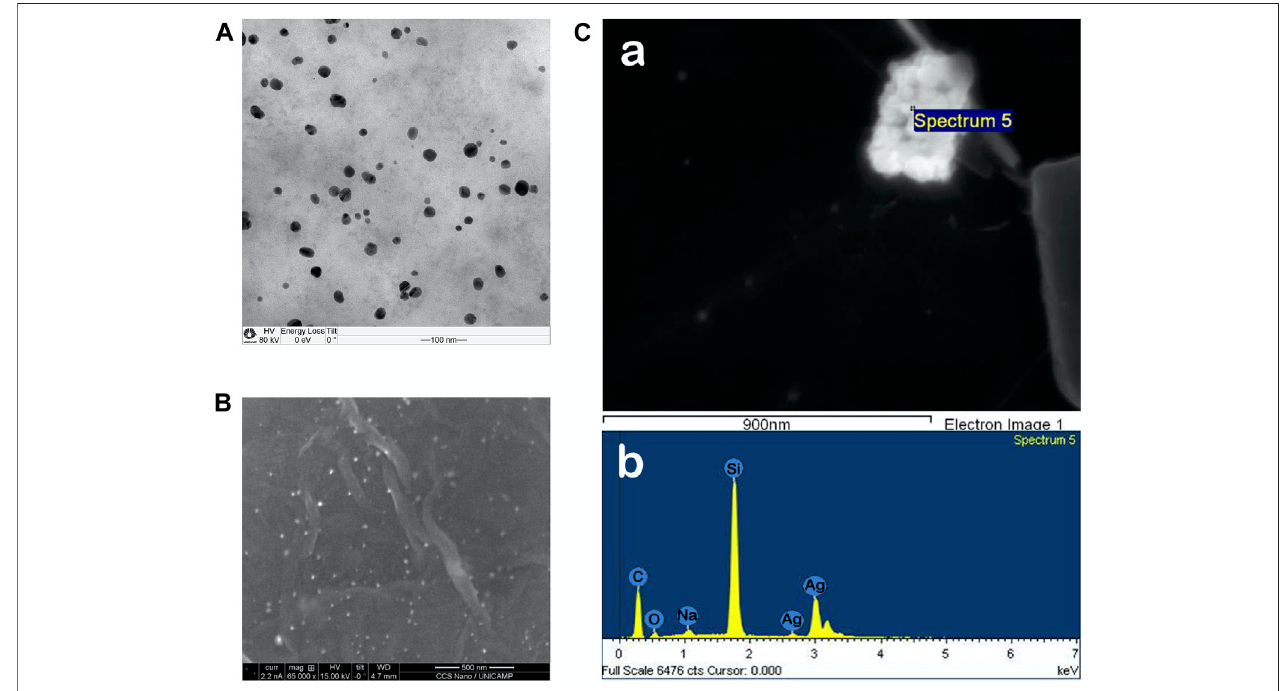
FIGURE 1 | (A) TEM image of AgNP@HST showing the distribution of particles with 22 nm in diameter (scale bar = 100 nm). (B) SEM image of a CNF@GO@ AgNP@HSTcompositedecoratedwithAgNP@HSTas20 nmbrightspots(scalebar=500 nm) (C) GOsheetdecoratedwithAgNP@HSTparticles(Spectrum5)andits EDS graph.